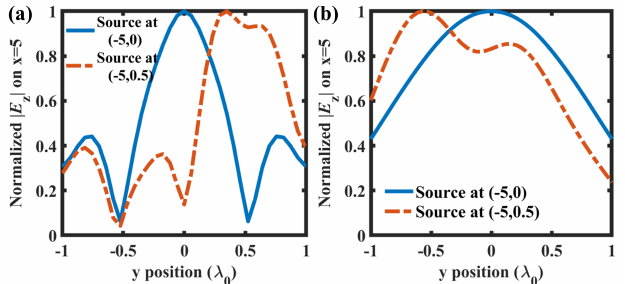
Figure 6. Normalized | E z | at the receiving line (at x = 5) excited by the two point sources at the positions ( − 5, 0) and ( − 5, 0.5): ( a ) (cid:101) r = 3, R = 2.4 λ 0 ; ( b ) (cid:101) r = 6, R = 2 λ 0